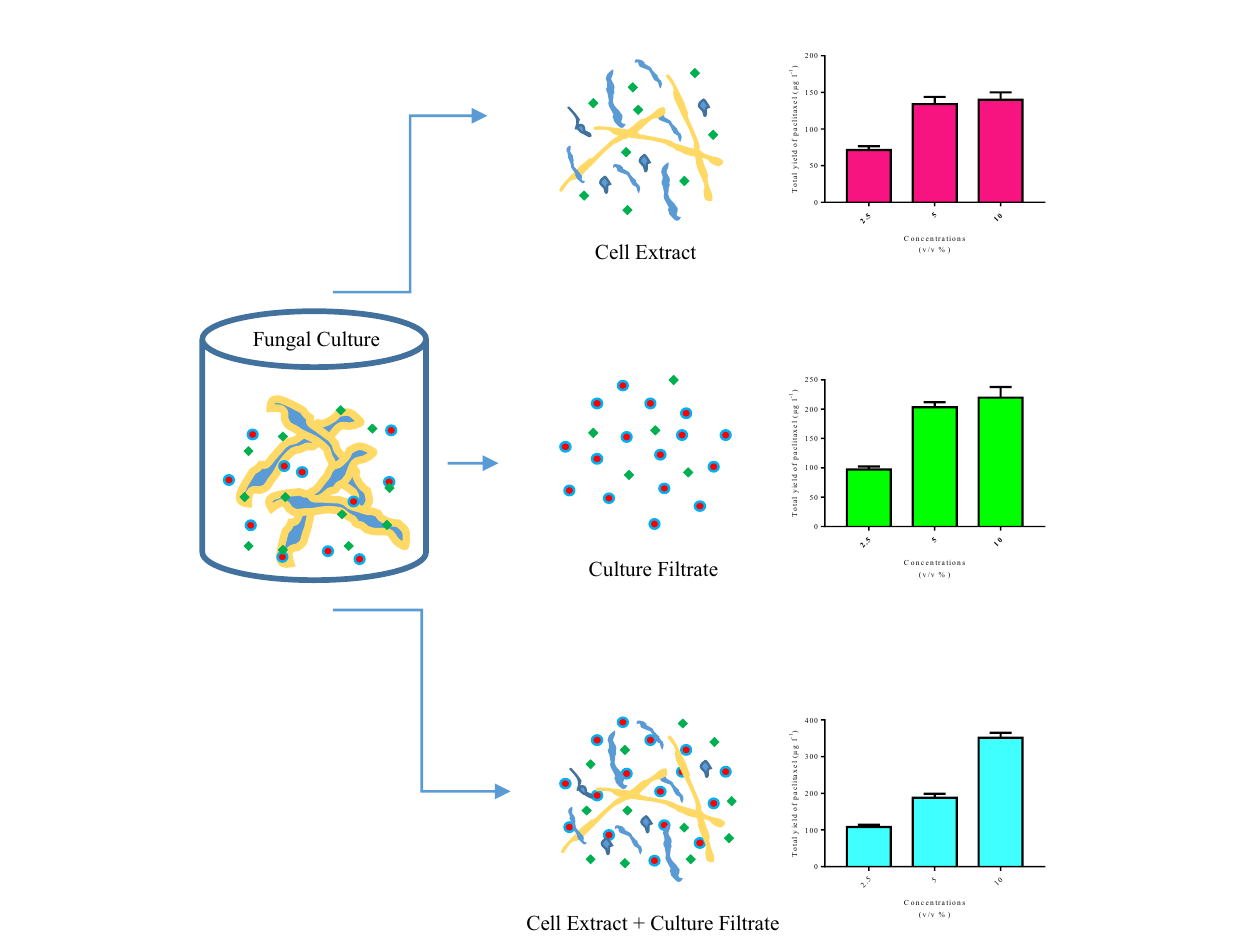
FIGURE 6 | Schematic design of microbe-associated molecular patterns (MAMPs) found in cell extract and culture fi ltrate, and total yield of paclitaxel in Corylus avellana cell cultures exposed with different concentrations of these fungal elicitors derived from Camarosporomyces fl avigenus